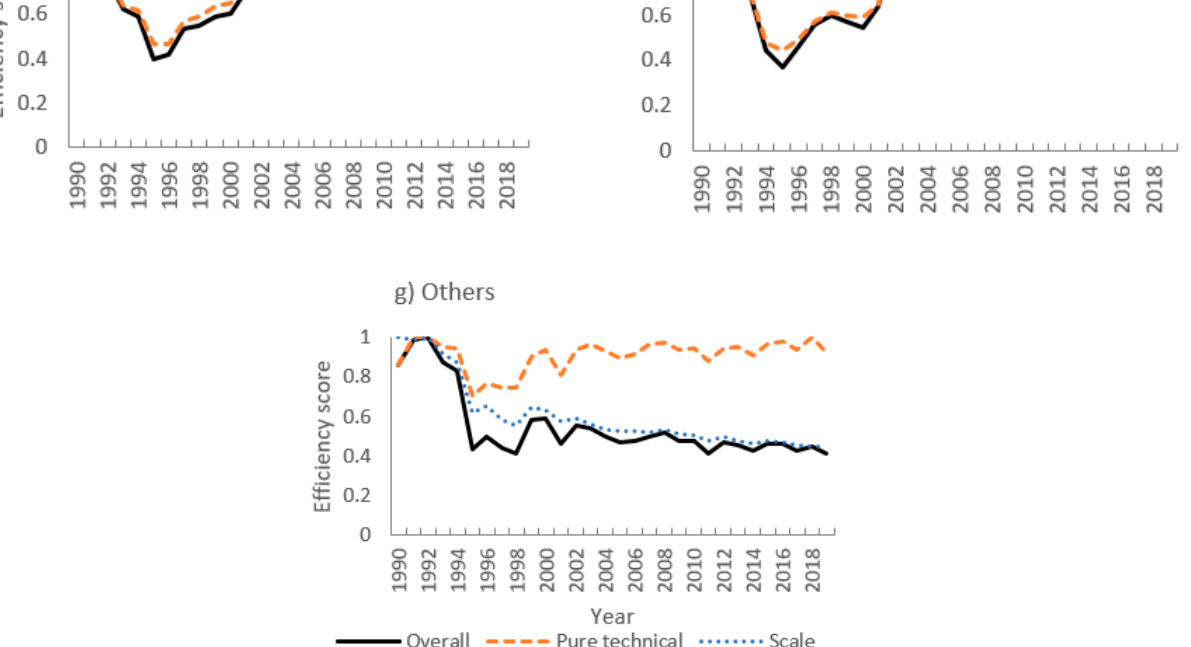
Figure 3. Technical efficiencies of inputs to timber production by State Forests in Poland in 1990–2019.